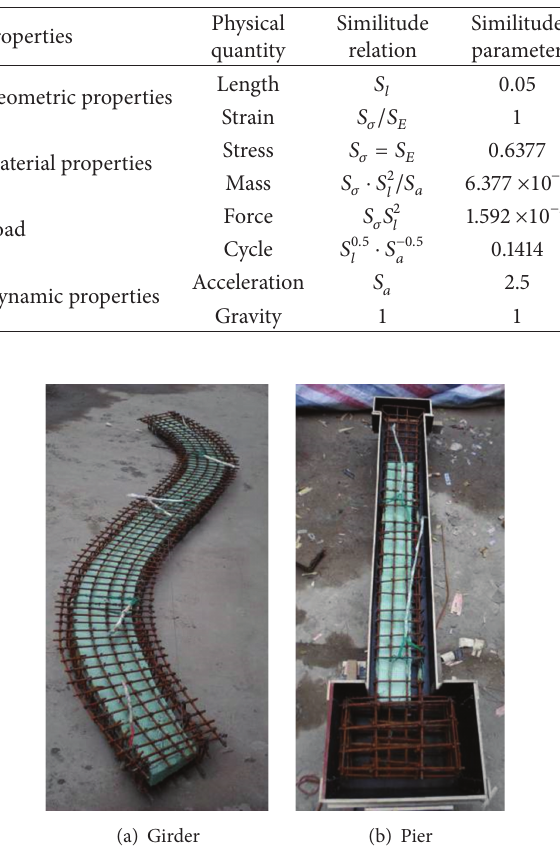
Figure 1: Reinforcement